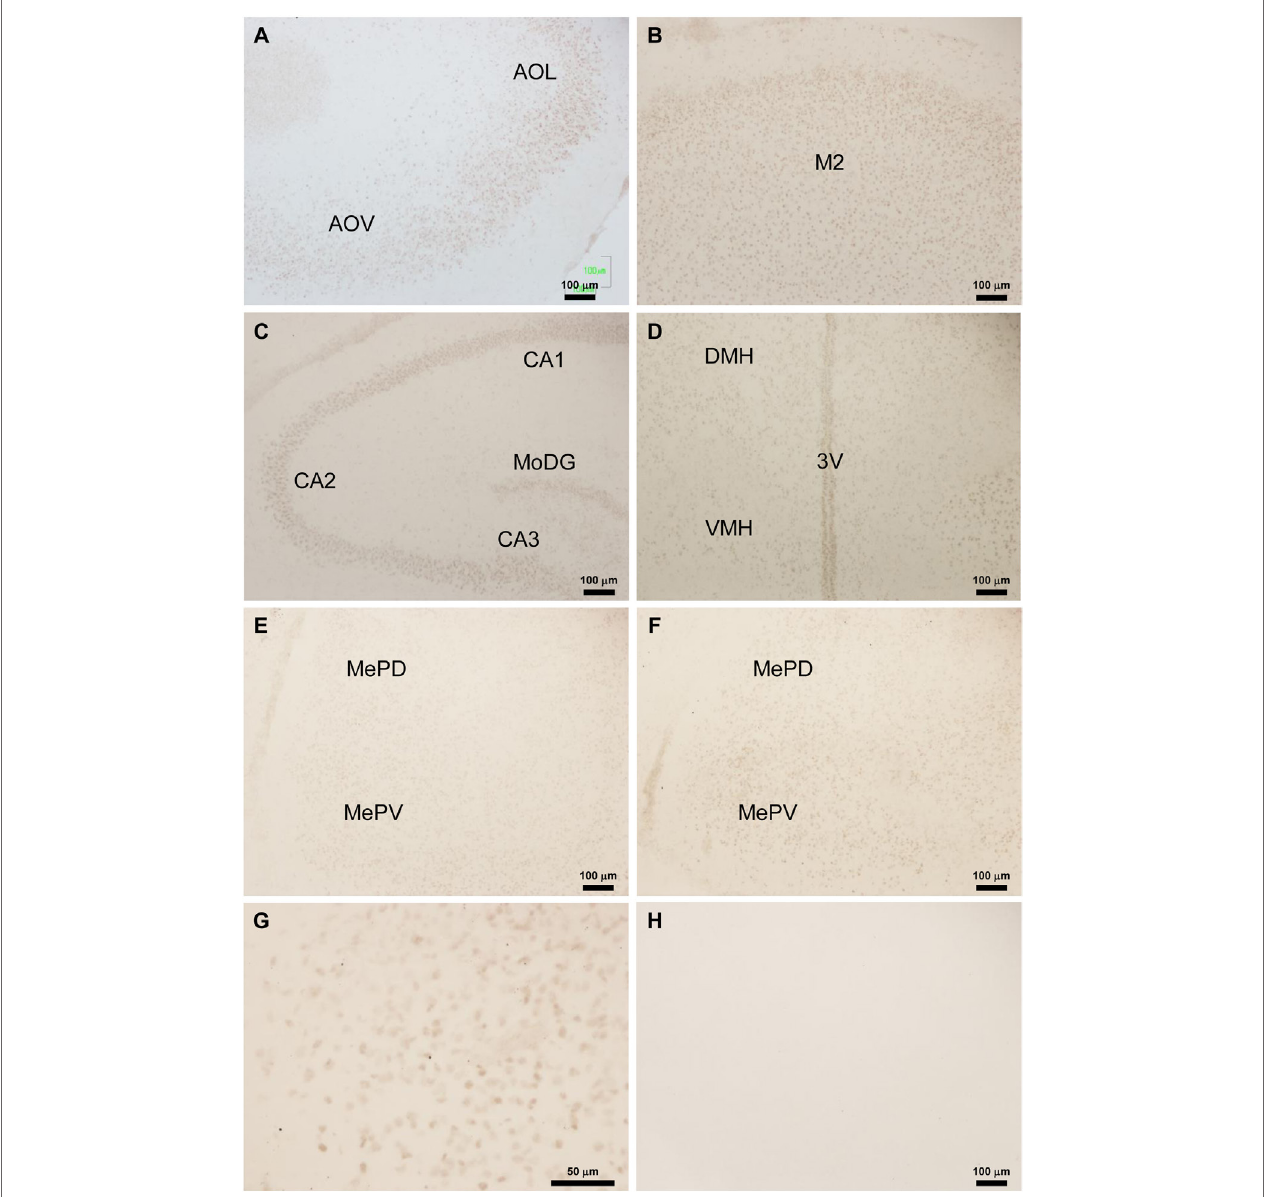
FigUre 2 | Location of Tmprss2-immunoreactive cells in the neonatal male rat brain. (a) Tmprss2-immunoreactive (ir) cells in the olfactory bulb of Bisphenol A (BPA) treated P3 rat. AOL, anterior olfactory nucleus, lateral part. AOV, anterior olfactory nucleus, ventral part. (b) Tmprss2-ir cells in the secondary motor cortex (M2) of BPA treated P3 rat. (c) Tmprss2-ir cells in the hippocampus of BPA treated P3 rat. CA1, field CA1 of the hippocampus; CA2, field CA2 of the hippocampus; CA3, field CA3 of the hippocampus; MoDG, molecular layer of the dentate gyrus. (D) Tmprss2-ir cells in the hypothalamus of BPA treated P3 rat. DMH, dorsomedial hypothalamic area; VMH, ventromedial hypothalamic area; 3V, third ventricle. (e) Tmprss2-ir cells in the amygdala of vehicle treated P3 rat. MePD, medial amygdaloid nucleus, posterodorsal part; MePV, medial amygdaloid nucleus, posteroventral part. (F) Tmprss2-ir cells in the amygdala of BPA treated P3 rat. (g) Higher magnification of MePV of BPA treated P3 rat (F) . (h) Immunohistochemistry without the first antibody showed no immunoreactive cellular